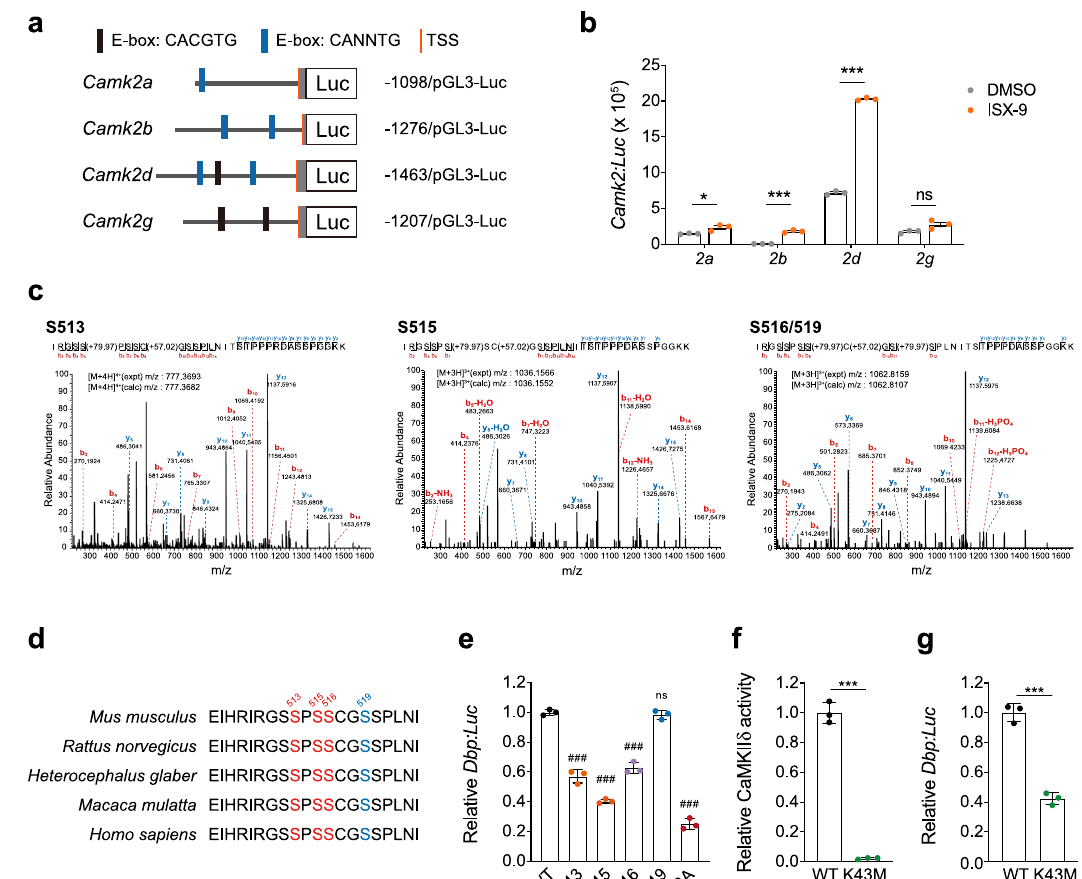
Fig. 6 ISX-9 prompted BMAL1 activity through S513/515/516 phosphorylation. a Schematic diagram of E-box containing mCamk2 promoter constructs. b Camk2 :Luc bioluminescence assay in N2a cells treated with DMSO or 10 μ M ISX-9. c Mass spectrometry identi fi cation of potential BMAL1 phosphorylation sites responded to ISX-9 treatment in N2a cells. d Amino acid sequence alignment of BMAL1 among the indicated species, S513, S515, and S516 were marked in red, and S519 in blue. e Dbp :Luc bioluminescence assay with expressing BMAL1 WT or mutants in N2a cells. One-way ANOVA with Bonferroni correction for multiple comparison was performed (ns, not signi fi cant, ### p < 0.001), and data were shown as mean ± SD. f In vitro kinase assay of puri fi ed CaMKII δ WT and K43M mutant, using BMAL1 as the substrate. g Dbp :Luc bioluminescence assay with expressing CaMKII δ WT or K43M mutant. b , f , g Unpaired Student ’ s t -test was used (ns not signi fi cant, * p < 0.05, *** p < 0.001), and data were shown as mean ± Protein puri fi cation and kinase assay . For BMAL1 and CaMKII puri fi cations, pCAGGS plasmids (5 μ g) encoding FLAG- Bmal1 , FLAG- Camk2 isoforms, and mutants were transfected individually into 2 ×10 6 HEK293T cells. After expressing for 48 h, cells were harvested and lysed in 400 μ l lysis buffer containing protease inhibitor (Roche). Approximately 3 mg of cell lysates were incubated with 20 μ l anti-FLAG M2 magnetic beads (Sigma) for 4h at 4 °C, then cleaned the impurities via TBS buffer (50 mM Tris at pH 7.5, 150mM NaCl) washes three times, before the elution by 100 μ l of 3X FLAG peptide (150ng/ μ l, Sigma). Kinase assays were